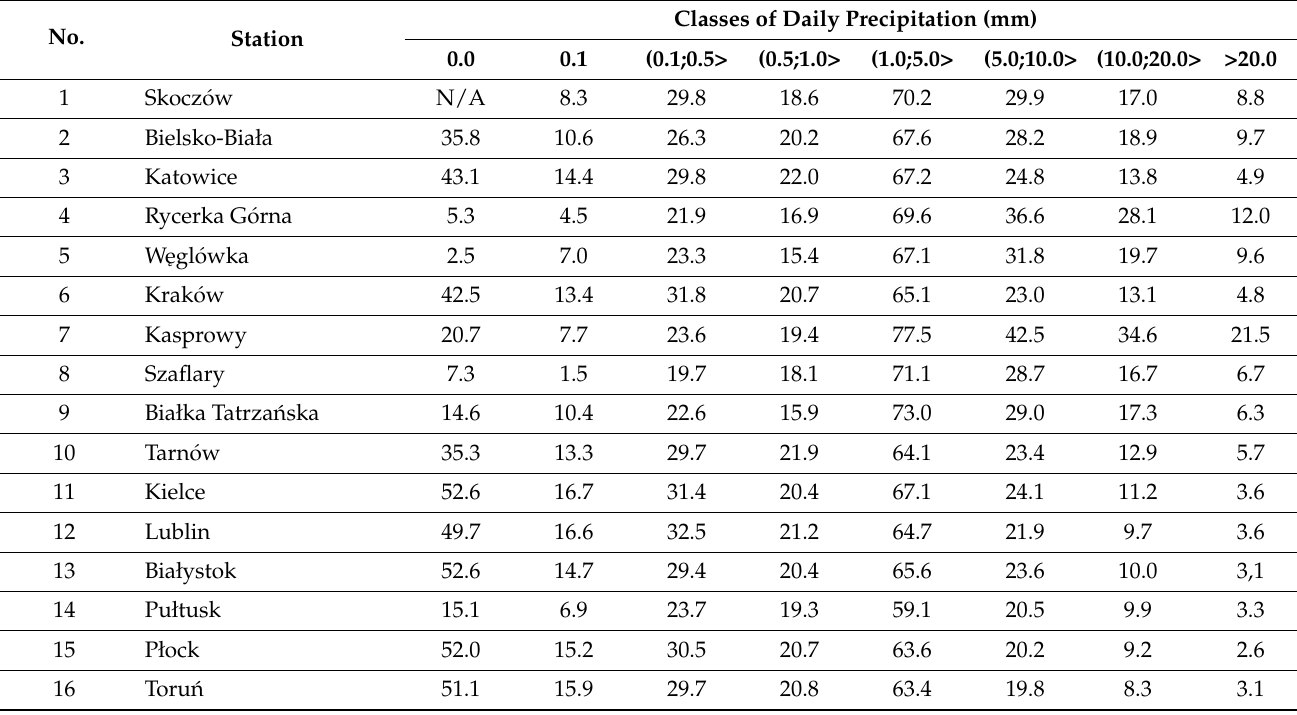
Table 2. Structure of daily precipitation; mean annual number of days in classes of precipitation amount in the observation period (see Table